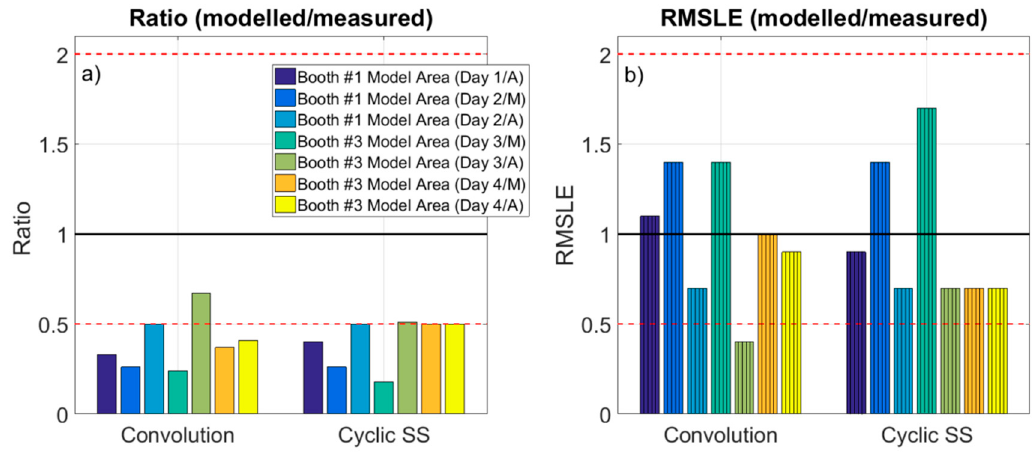
Figure 3. Ratio modeled / measured concentrations (a) , and RMSLE (modeled / measured) (b) . Ratio 0.5 and 2 are marked as reference (dashed line). Cyclic SS: cyclic steady state equation.